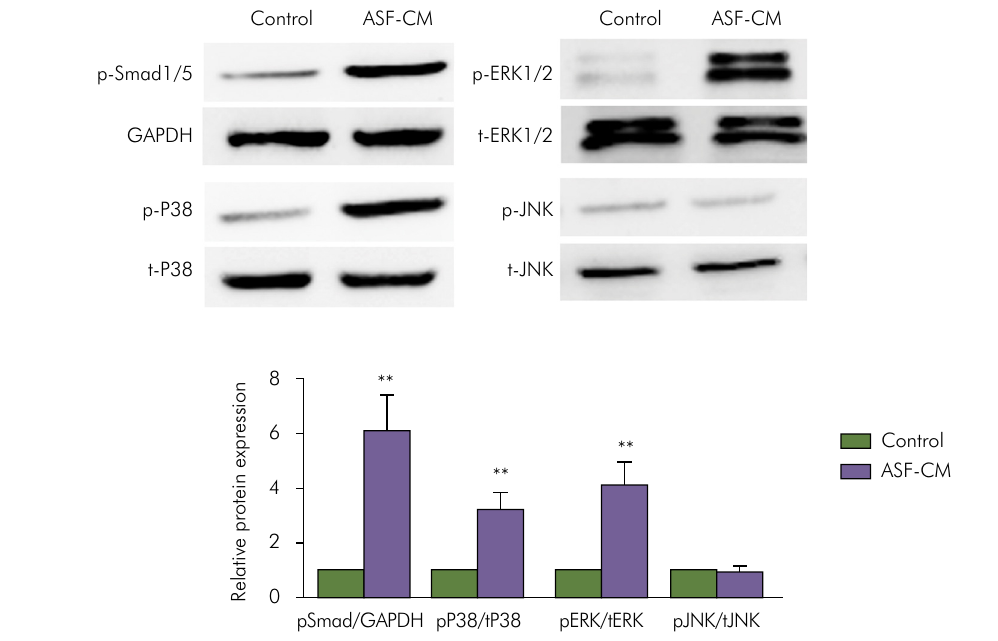
Figure 4. Western blotting analysis and quantification of the phosphorylation level of SMAD1/5 and P38, ERK1/2, and JNK MAPKs pathways in iPS cells induced by control medium or ASF-CM. **p < 0.01, vs . control